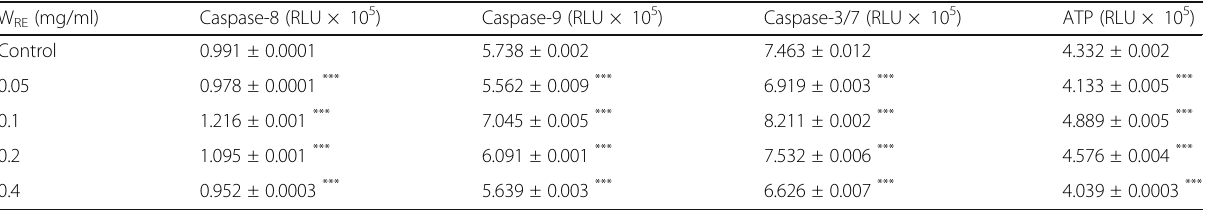
Table 5 Modulation of caspase (-8, -9, -3/7) activity and ATP levels in LPS-stimulated and 72 h W RE -treated THP-1 cells W RE (mg/ml)